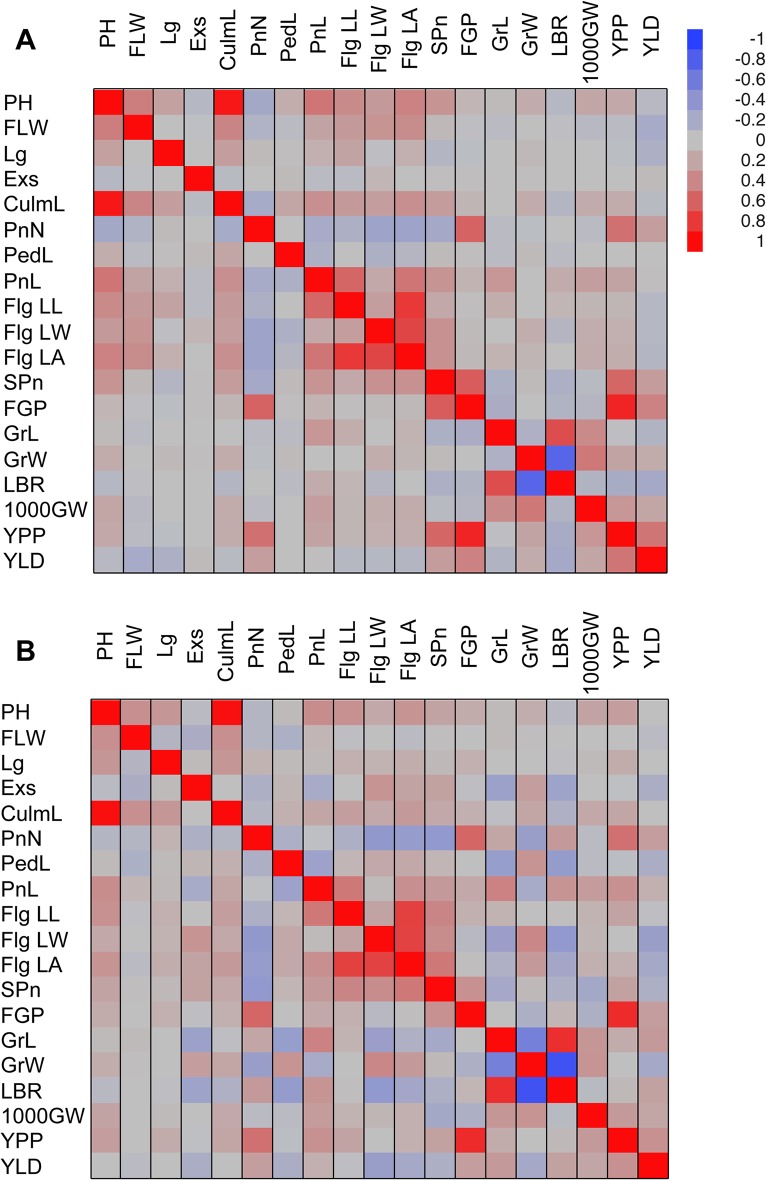
Graphic representation of the correlation matrices of phenotype values for the (A) dry season, and (B) wet season.